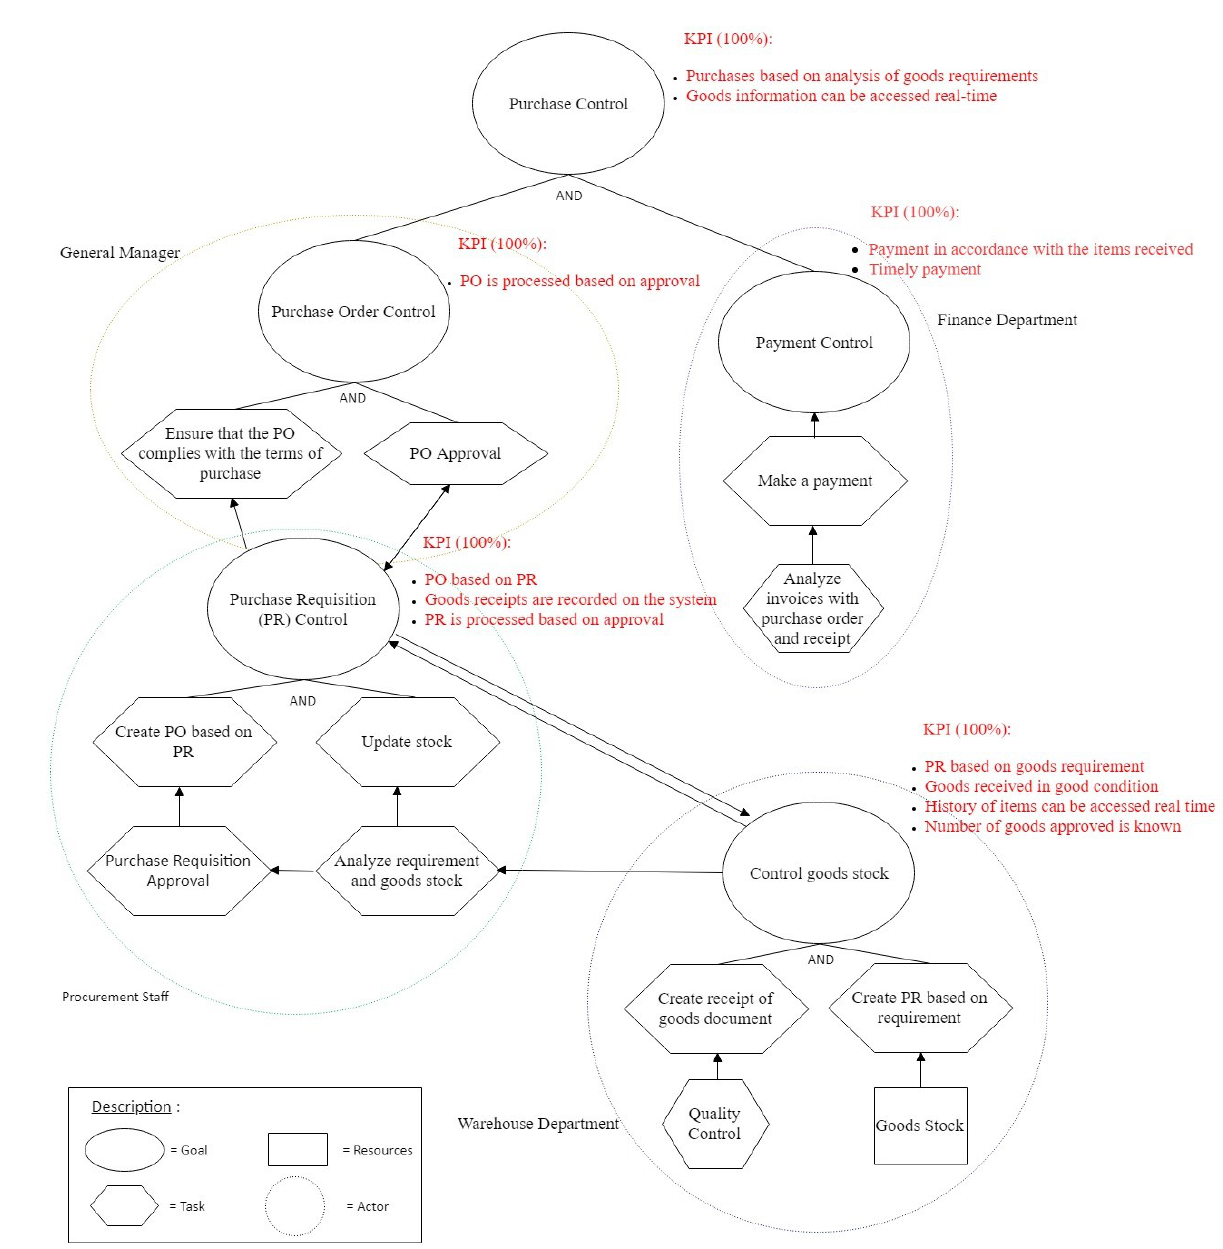
Figure 2: Improved GTM of Purchase